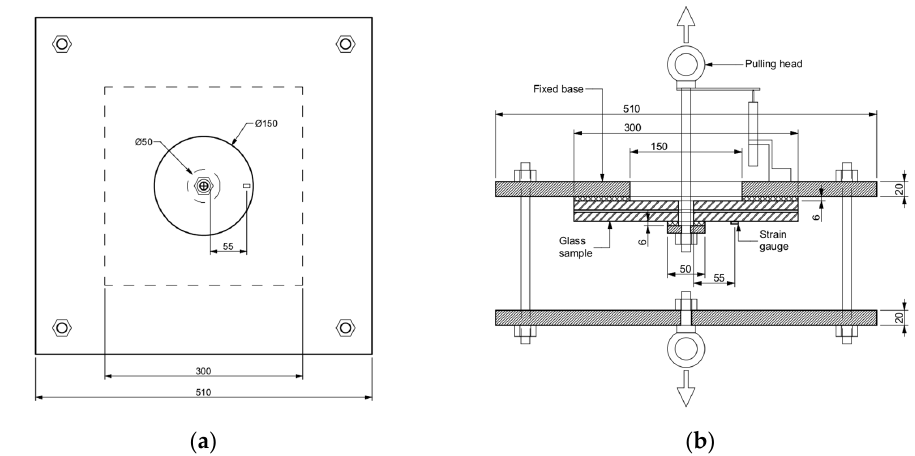
Figure 3. Experimental set ‐ up: ( a ) plan view; ( b ) cross ‐ section. Dimensions in